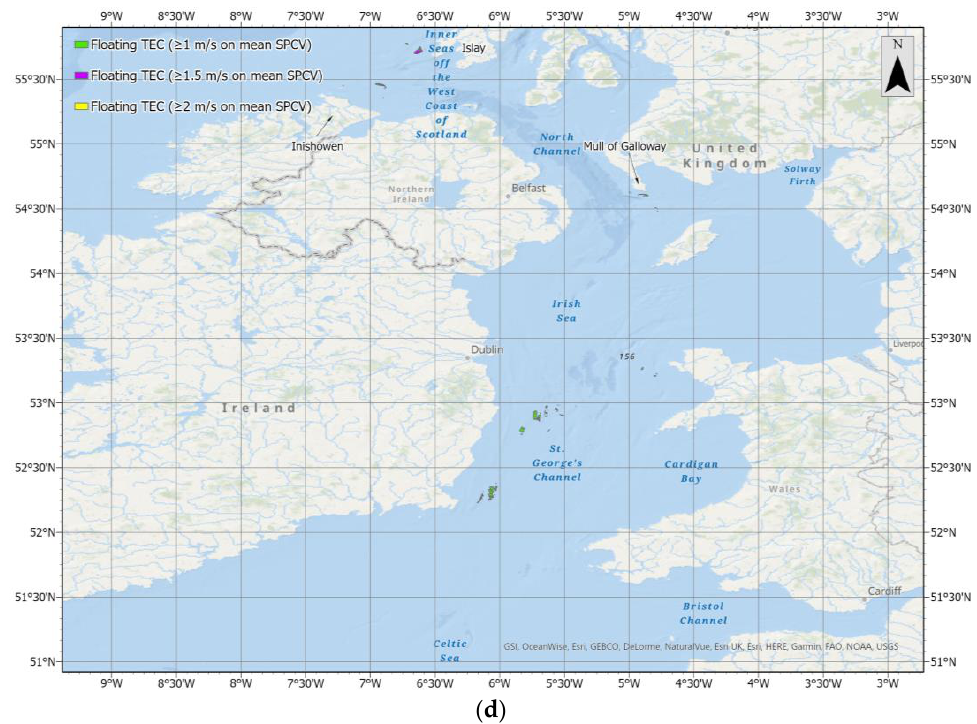
Figure 23. ( a ) Potential sites for tidal energy deployment based on survey responses from a Fixed Bottom TEC technology developer. ( b ) Potential sites for tidal energy deployment based on survey responses from a Floating TEC technology developer. ( c ) Optimum sites for tidal energy deployment based on survey responses from a Fixed Bottom TEC technology developer. ( d ) Optimum sites for tidal energy deployment based on survey responses from a Floating TEC technology developer.